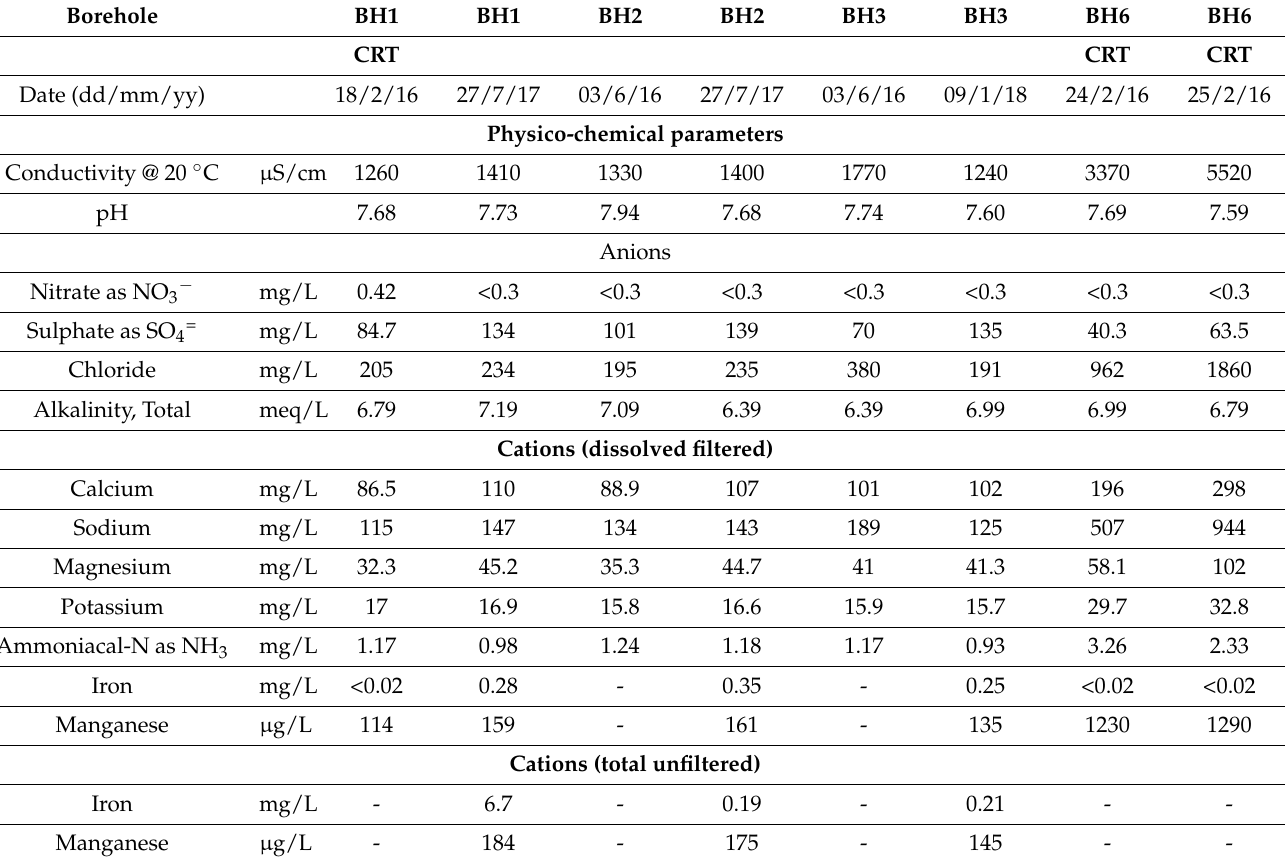
Table 3. Selected water chemistry data from pumping of the Abbotsford Road boreholes (CRT = sampled during constant rate testing). See Figure 2 for borehole